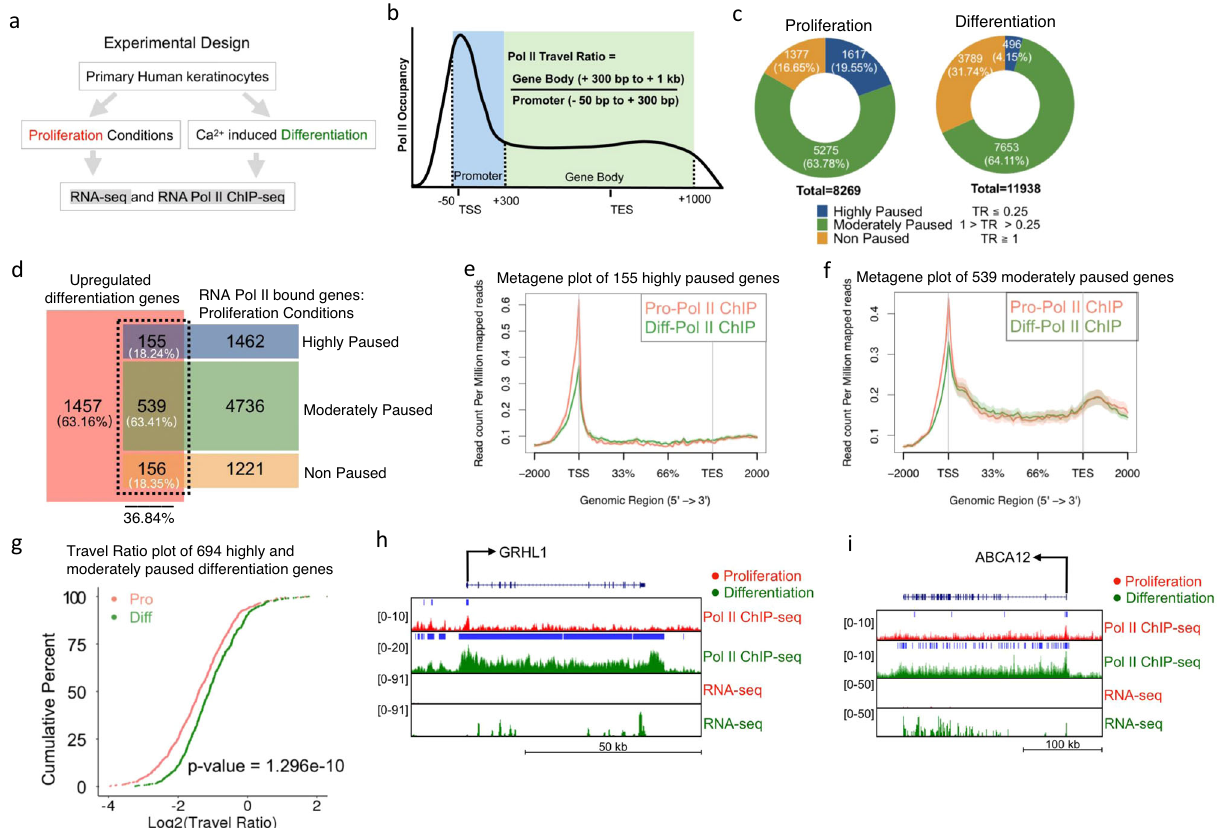
Fig. 1 Promoter proximal pausing controls differentiation gene expression. a Diagram of the experimental design. Primary human keratinocytes were either grown in proliferation or differentiation conditions and subjected to RNA Pol II ChIP-Seq. b Schematic representation describing the calculation of the travel ratio (TR) for genes bound by Pol II. The promoter proximal region is de fi ned as 50 bp upstream to 300 bp downstream of the transcription start site (TSS). The gene body is de fi ned as 300 bp downstream of the TSS to 1 kb downstream of the transcription end site (TES). c Donut chart of percentage of genes that are highly paused (TR ≤ 0.25), moderately paused (1 > TR > 0.25), non-paused (TR ≥ 1) in proliferation and differentiation conditions. Genes that contained signi fi cant Pol II binding (Pol II ChIP-Seq) in either proliferation or differentiation conditions were subjected to TR analysis as described in b . N = 3 independent experiments for RNA Pol II ChIP-Seq in proliferation or differentiation conditions. d Overlap of upregulated differentiation genes with RNA Pol II bound genes in proliferation conditions. The Pol II bound genes have been categorized as highly paused (TR ≤ 0.25), moderately paused (1 > TR > 0.25), or non-paused (TR ≥ 1). e Metagene plot of the 155 differentiation genes highly paused in proliferation conditions. Pol II ChIP-Seq in proliferation (Pro) conditions is shown in red and compared to differentiation (Diff) conditions (shown in green). Read count per million mapped reads is shown on the Y -axis. The X -axis represents regions across genes. TSS is transcription start site and TES is transcription end site. The plot is an average of the triplicate samples for each group. f Metagene plot of the 539 differentiation genes moderately paused in proliferation conditions. Pol II ChIP-Seq in proliferation (Pro) conditions is shown in red and compared to differentiation (Diff) conditions (shown in green). The plot is an average of the triplicate samples for each group. g Travel ratio plot of the 694 differentiation genes highly and moderately paused in proliferation conditions. The average TR of genes in proliferation (Pro) conditions are shown in red and differentiation (Diff) conditions are shown in green. The Y -axis shows the cumulative percentage of genes and X -axis shows the travel ratio plotted in Log2. Gene tracks of two highly paused differentiation genes GRHL1 ( h ) and ABCA12 ( i ). Pol II ChIP-Seq tracks and RNA- Seq tracks are shown in proliferation (red) and differentiation (green) conditions. Y -axis shows reads per million and X -axis shows regions along the gene. Blue bars over gene tracks show signi fi cant